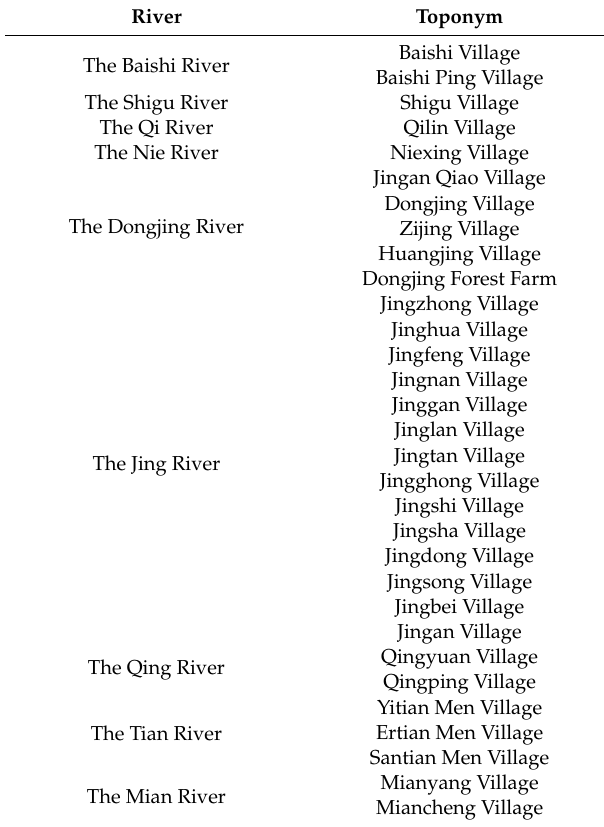
Table A1. Specific river